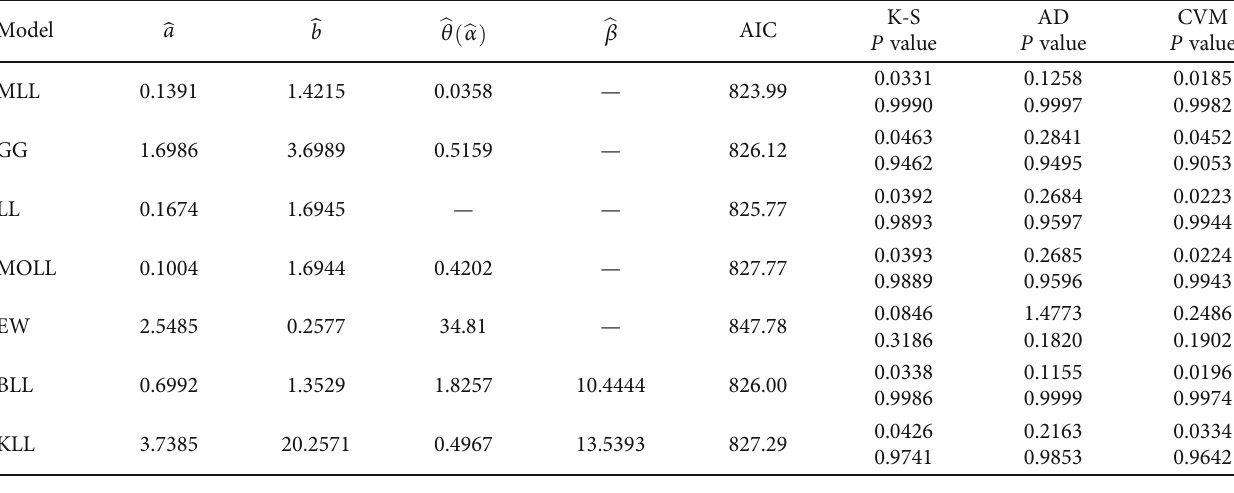
Table 5: Results of fi tting MLL and some alternative models to data set of Table 4.